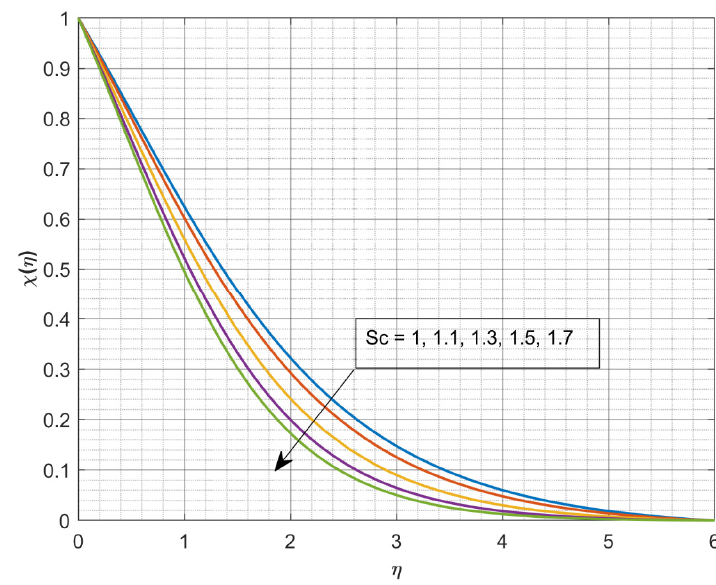
Figure 7. Influence of 𝑆𝑐 on 𝜒(𝜂) .